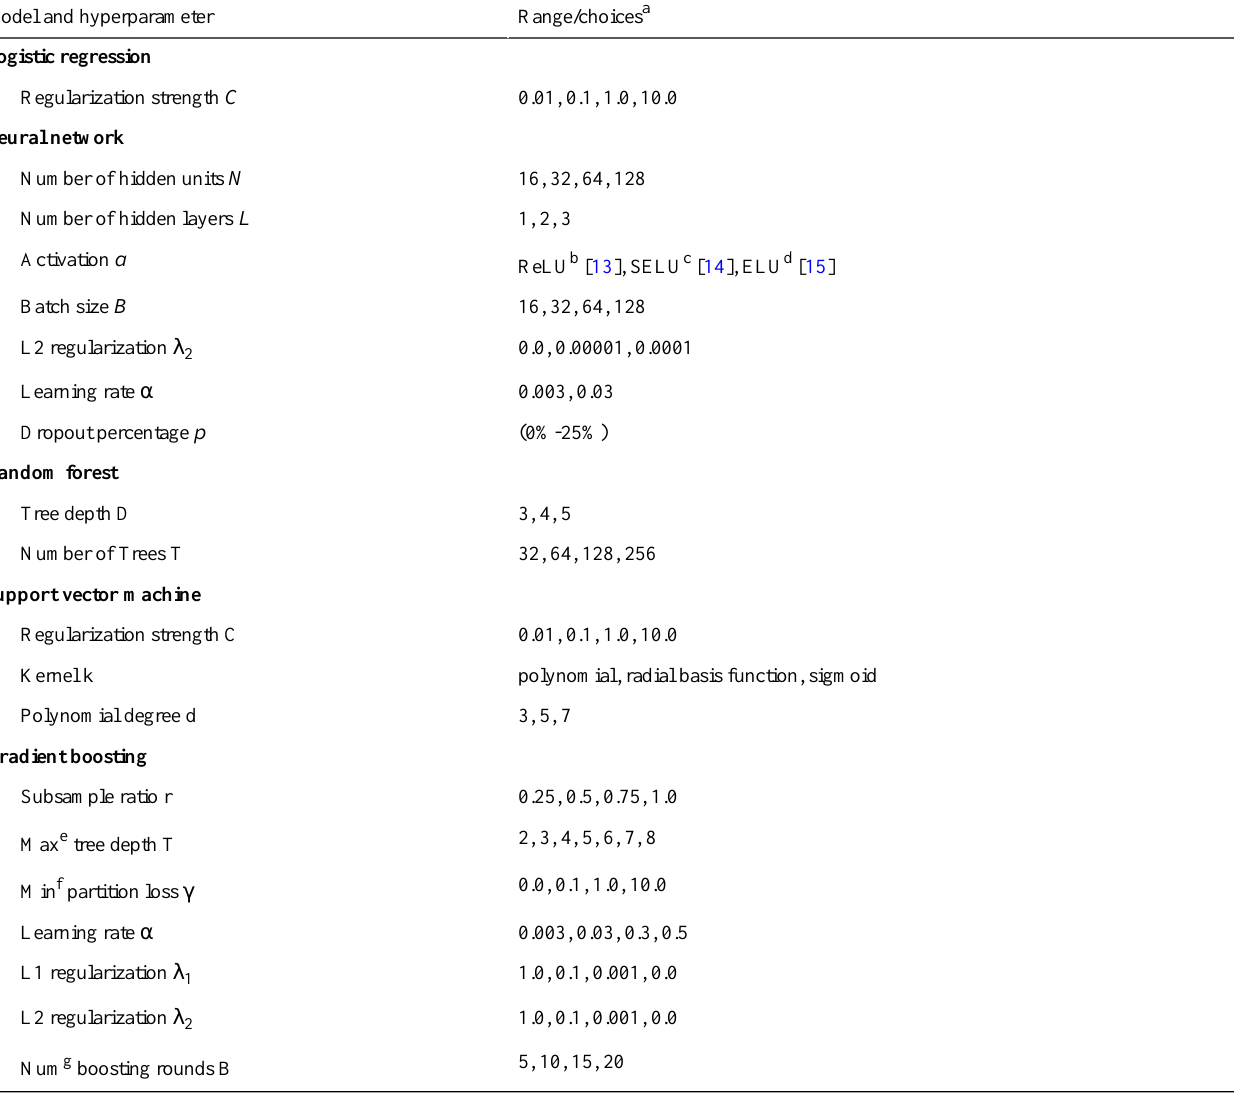
Table 2. Hyperparameter ranges used for hyperparameter optimization of logistic regression, neural network, random forest, support vector machine, and gradient boosting models for all tasks.